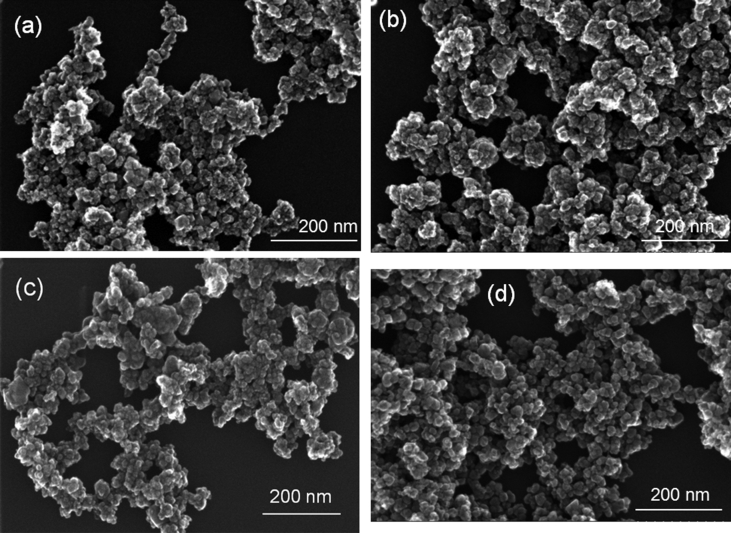
SEM images of ST-coated samples: (a) Fe3O4(av1), (b) Fe3O4(av2), (c) Fe3O4(wm) and (d) Fe3O4 samples.